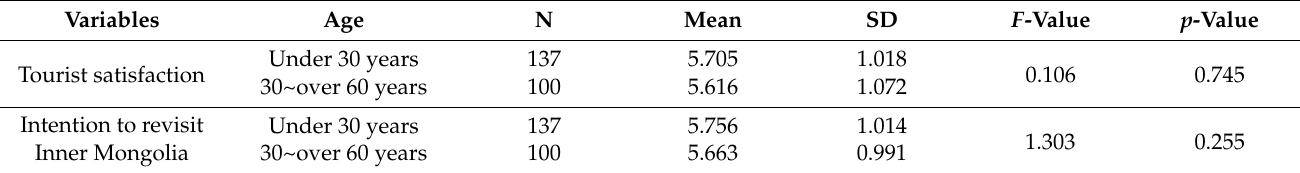
Table 6. Age differences in tourist satisfaction and intention to revisit Inner